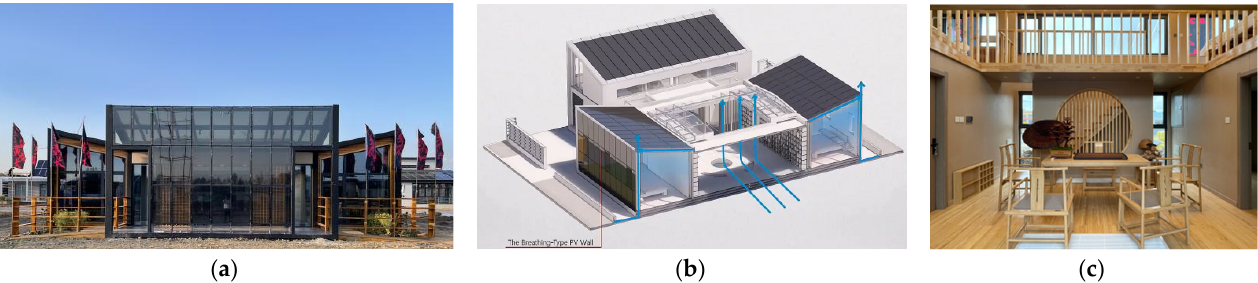
Figure 16. Main results of the Hope Land-Natural Courtyard. ( a ) Hope Land-Natural Courtyard. ( b ) PV air conditioning mechanism. ( c ) Wood use.